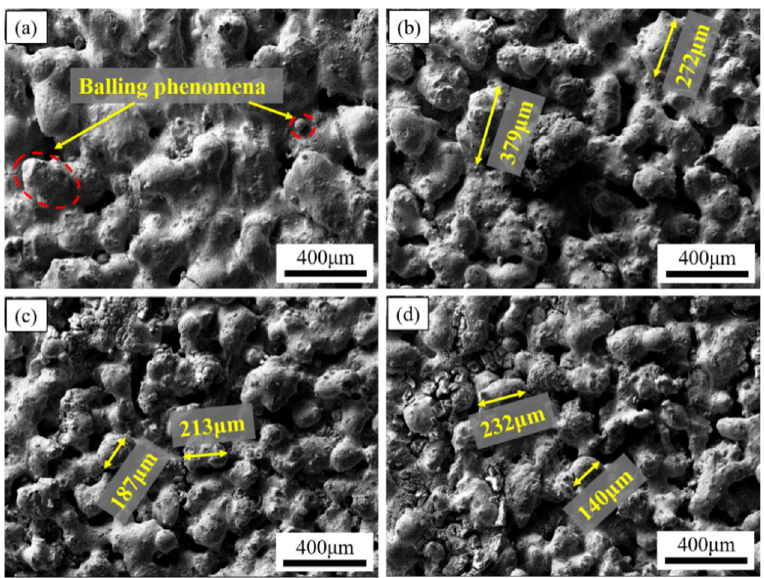
Figure 7. SEM images of Ti-Al-C-Nb sample surface morphologies at different scanning speeds with a laser power of 40 W: ( a ) 100 mm/s, ( b ) 200 mm/s, ( c ) 250 mm/s, ( d ) 300 mm/s.